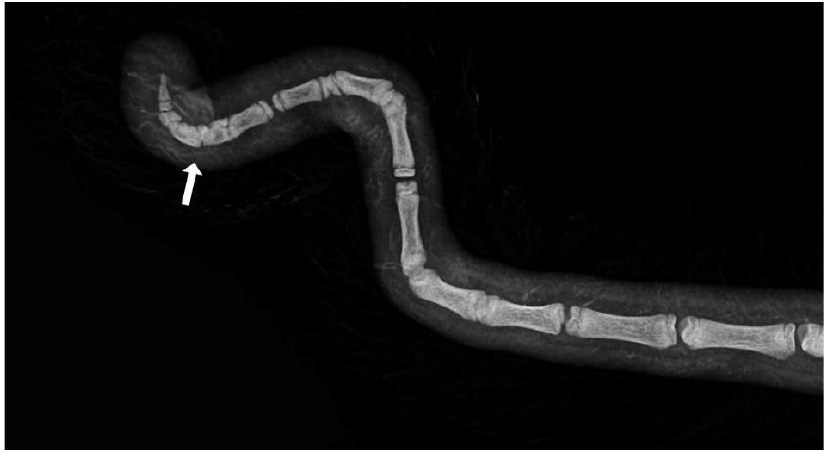
Figure 4. Section of an X-ray of a lamb’s tail with fractured vertebrae.